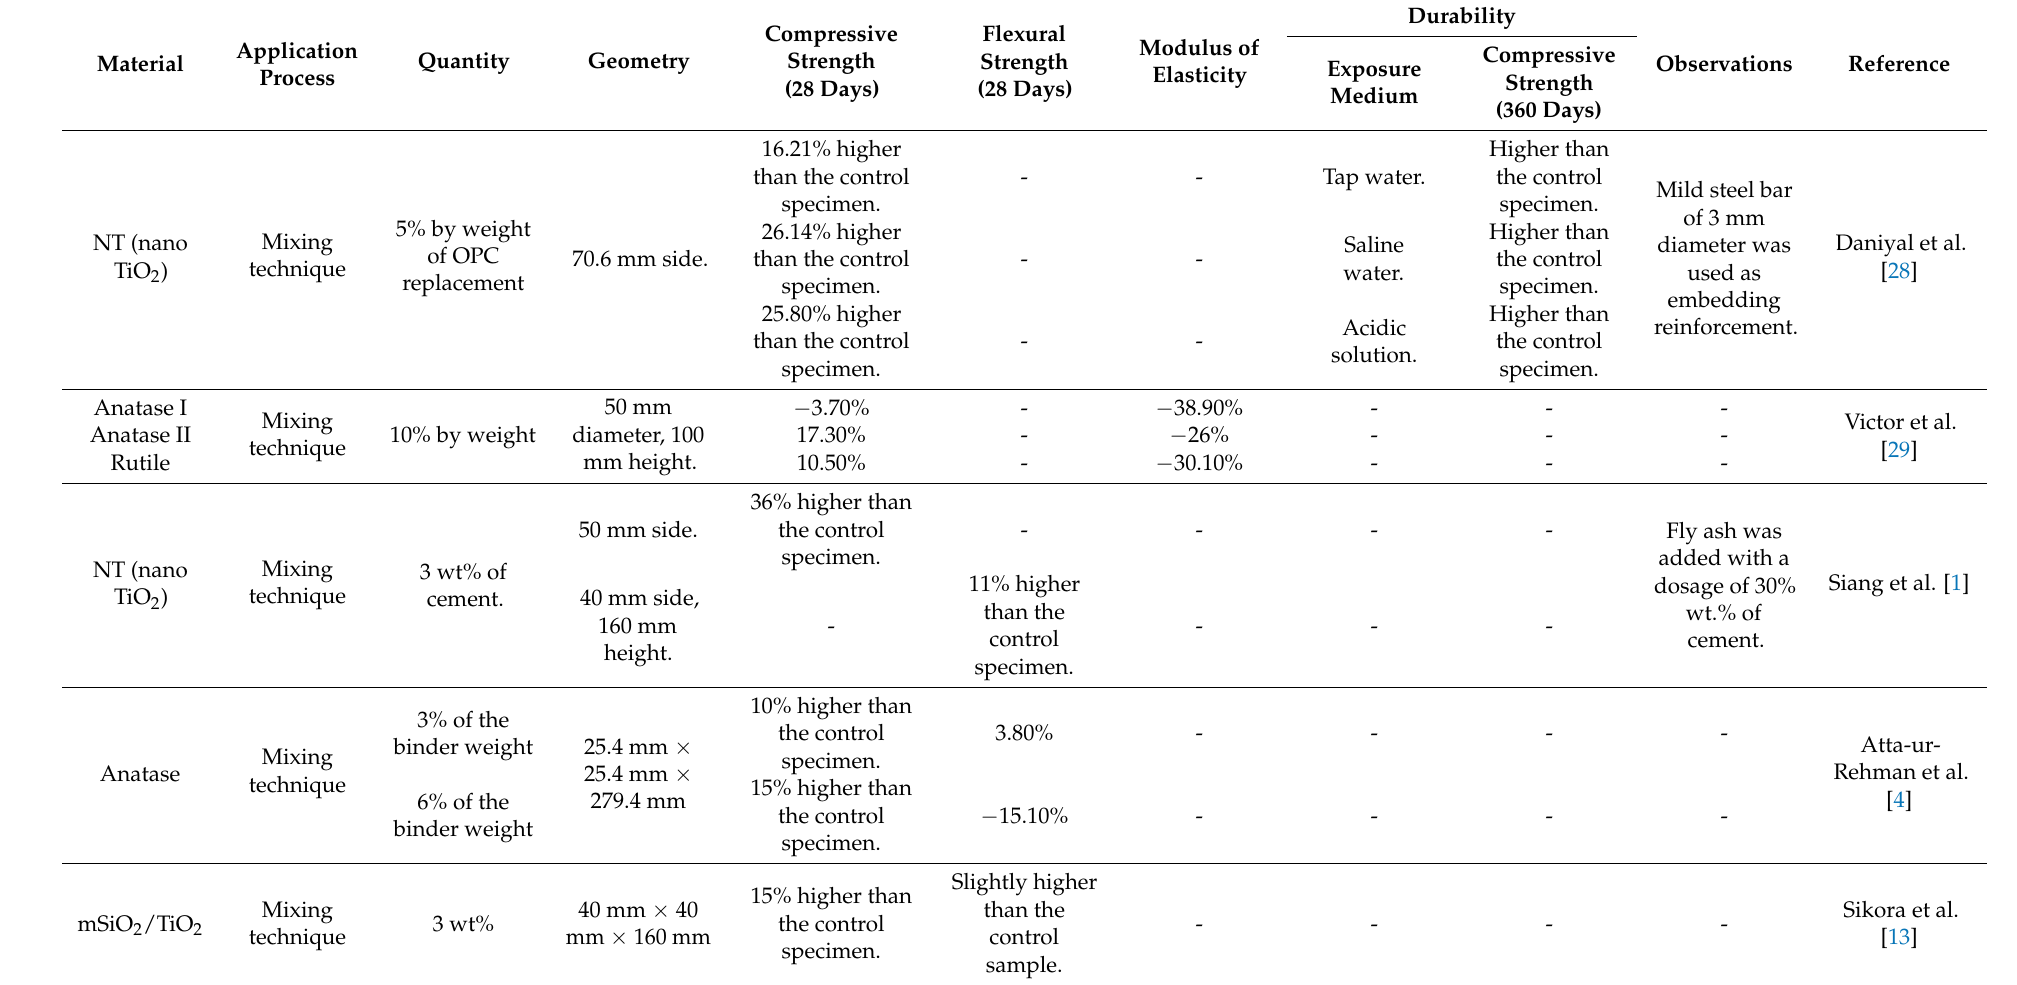
Table 1. Mechanical and durability properties of cementitious materials with titanium